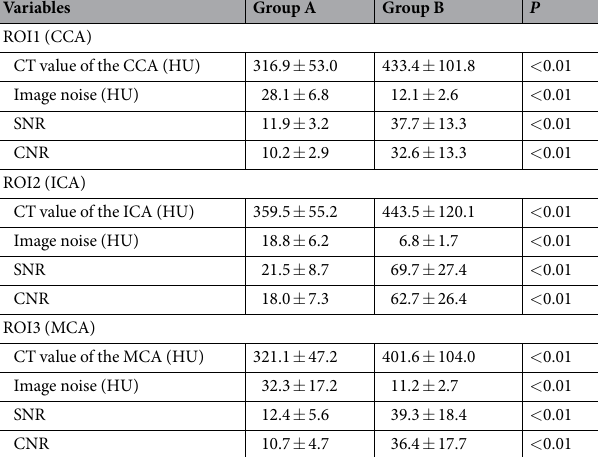
Table 3. Objective image quality evaluation. The data are the means ± standard deviations. Abbreviations: SNR, signal-to-noise ratio; CNR, contrast-to-noise ratio; CCA, common carotid artery; ICA, internal carotid artery; MCA, middle cerebral